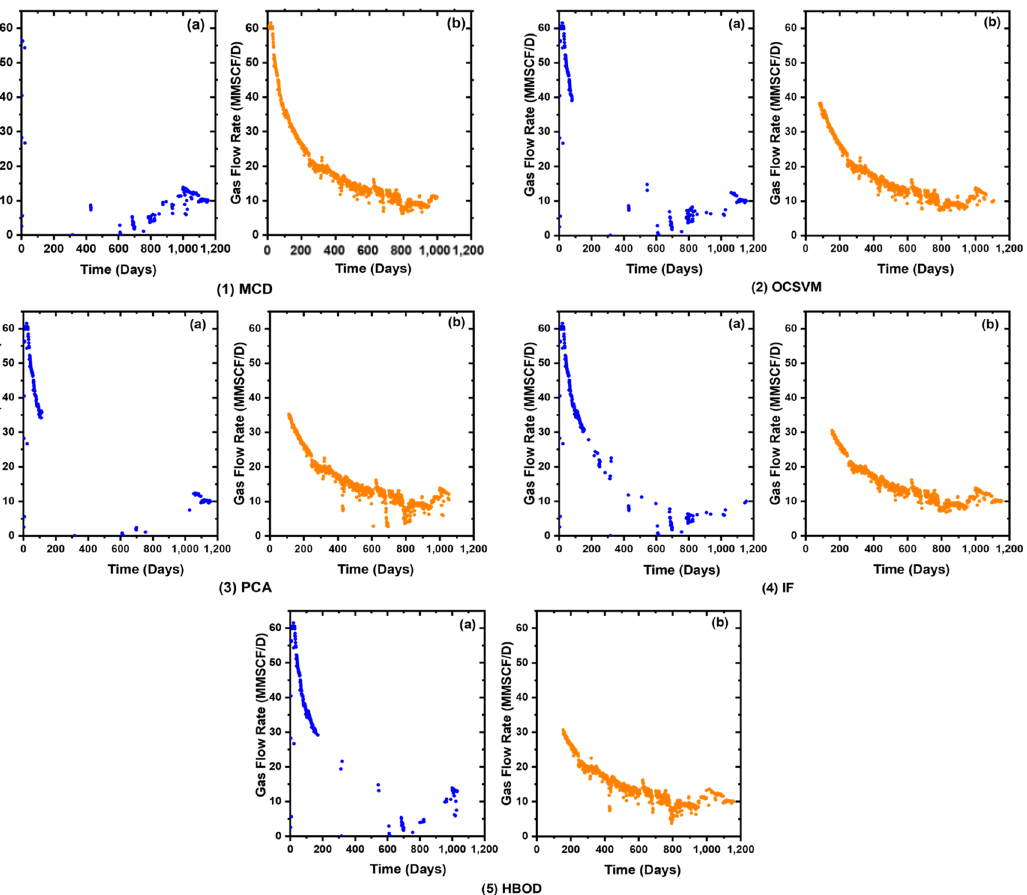
Figure 17. ( a ) Removed outliers and ( b ) production data after removing the outliers of Well_29 using; ( 1 ) MCD, ( 2 ) OCSVM, ( 3 ) PCA, ( 4 ) IF, and ( 5 ) HBOD algorithms.